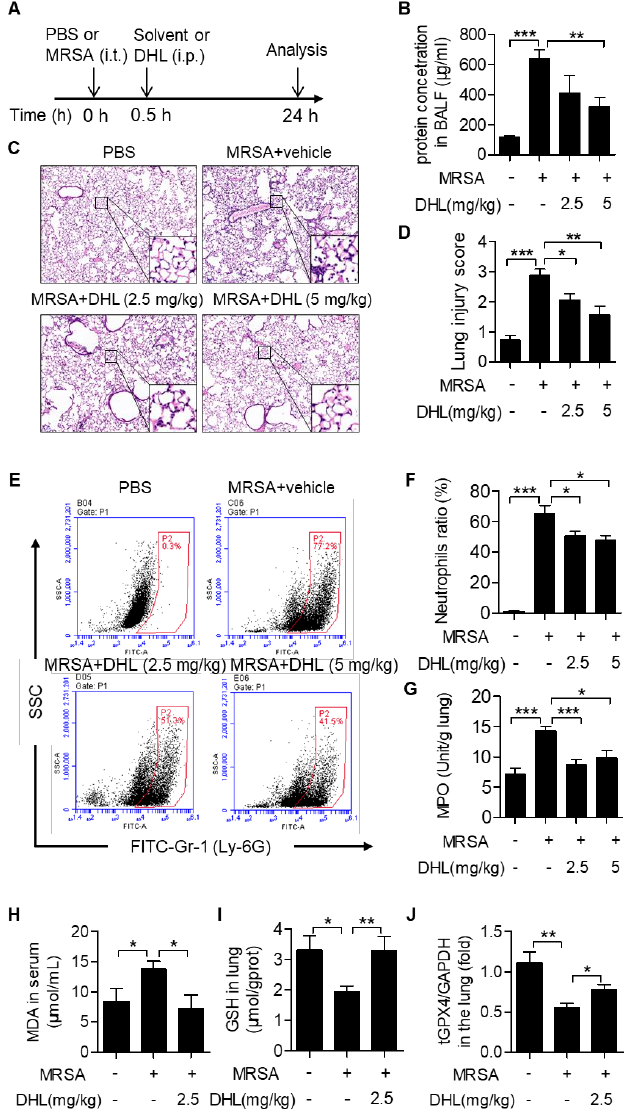
Figure 4. DHL alleviates MRSA-induced ALI in mice. ( A ) The schematic timeline of the MRSA- induced ALI mouse model. C57BL/6 mice were subjected to an intratracheal injection of MRSA (4 × 10 7 CFU/mouse) for 0.5 h, followed by intraperitoneal injection of vehicle